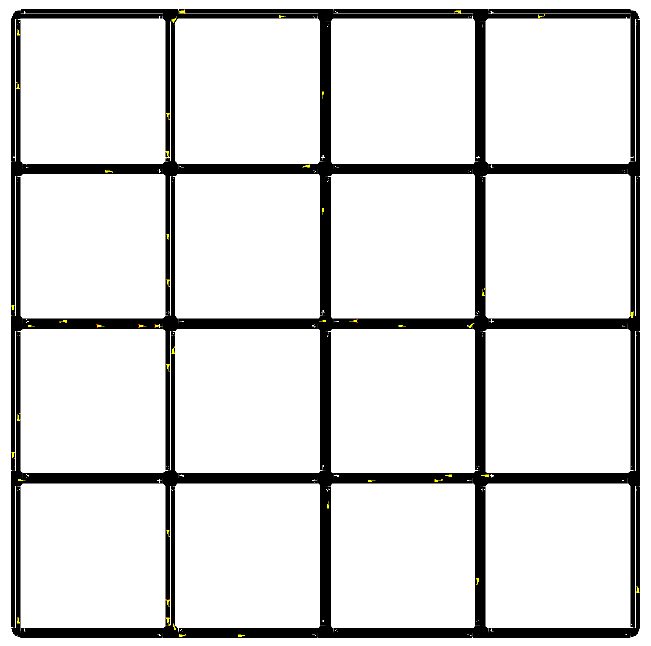
Figure 7. Urban grid scenario.